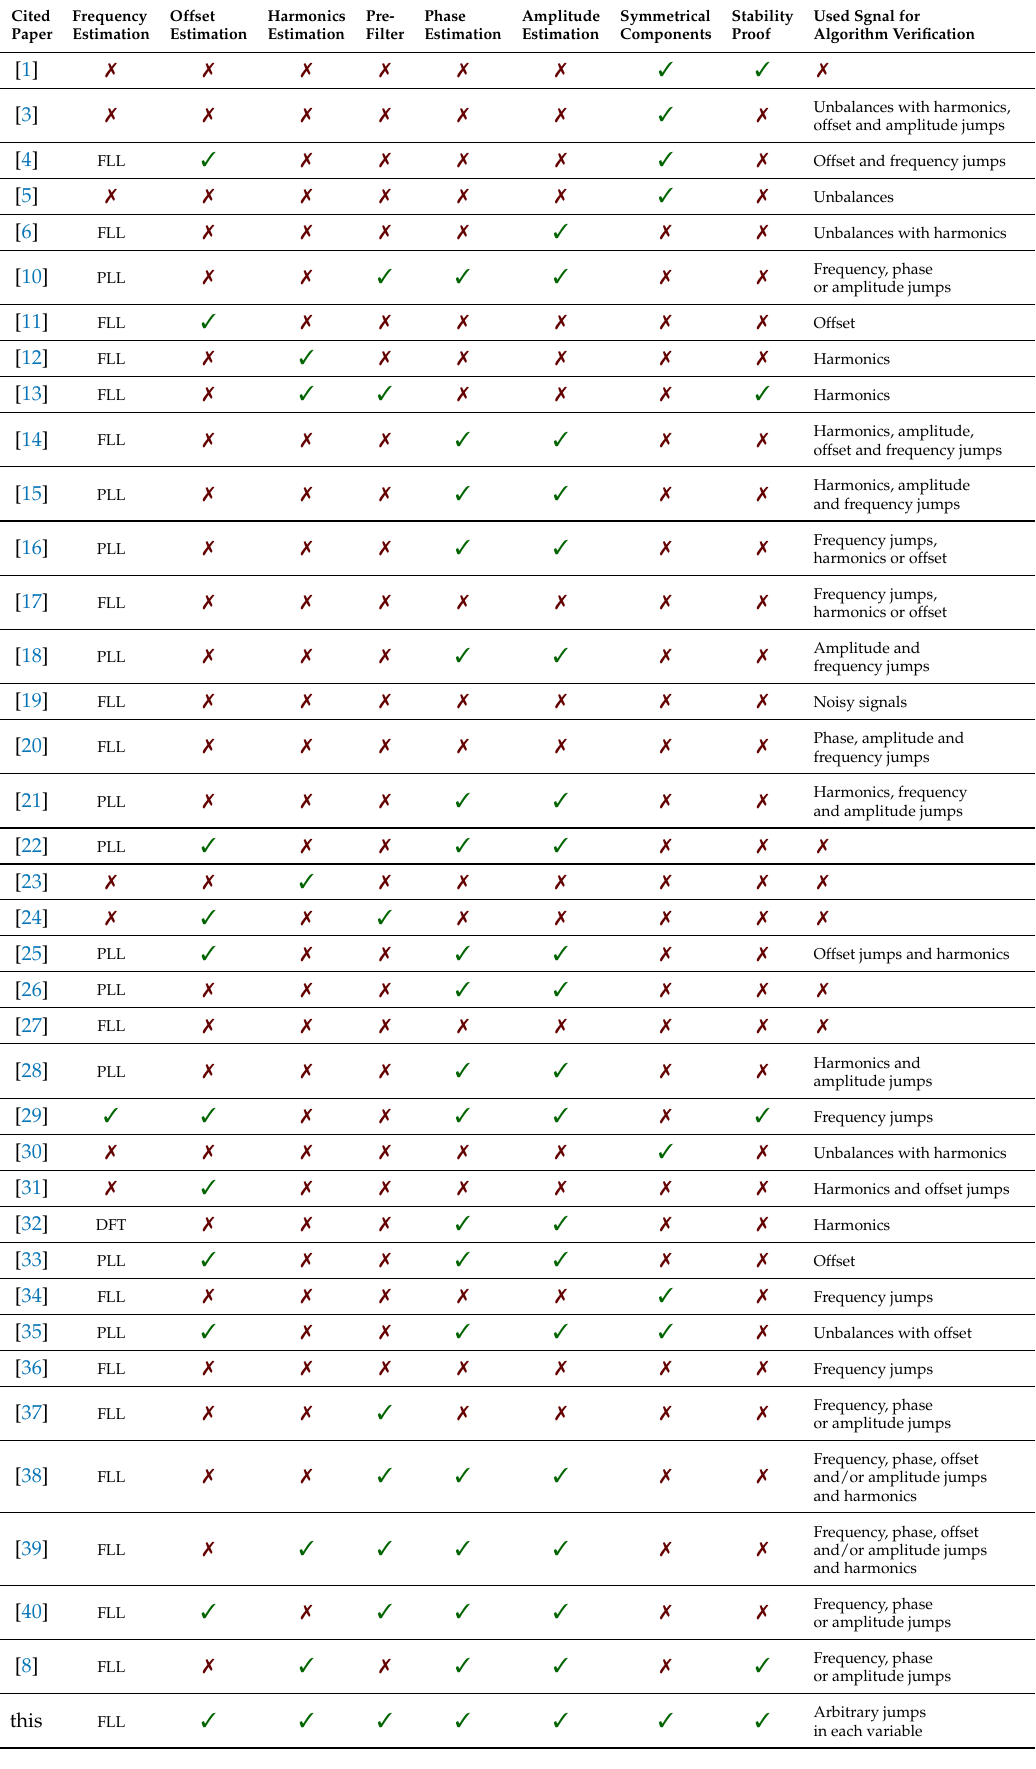
Table 1. Used processing methods and verification signals of the cited papers compared to this paper. Cited Frequency Offset Harmonics Pre- Phase Amplitude Symmetrical Stability Paper Estimation Estimation Estimation Filter Estimation Estimation Components